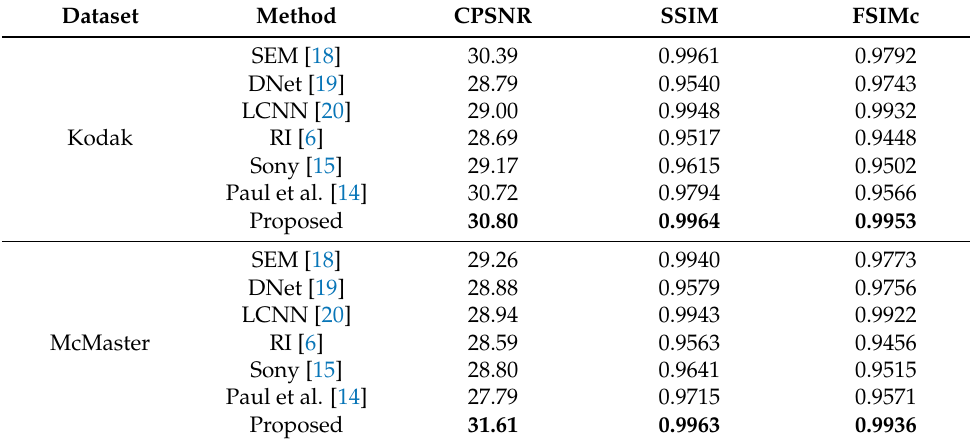
Figure 9. Visual comparison of the details in Figure 8 between the results of different demosaicing methods on the Kodak No. 19 image: ( a ) original ( b ) RI [6] ( c ) Sony [15] ( d ) Paul’s [14] ( e ) DNet [19] ( f ) SEM [18] ( g ) LCNN [20] ( h ) Proposed. Table 1. Comparison of the CPSNR, SSIM, and the FSIMc values between the various demosaicing methods on the Kodak and the McMaster image datasets with Low Noise Level. The largest values are in bold